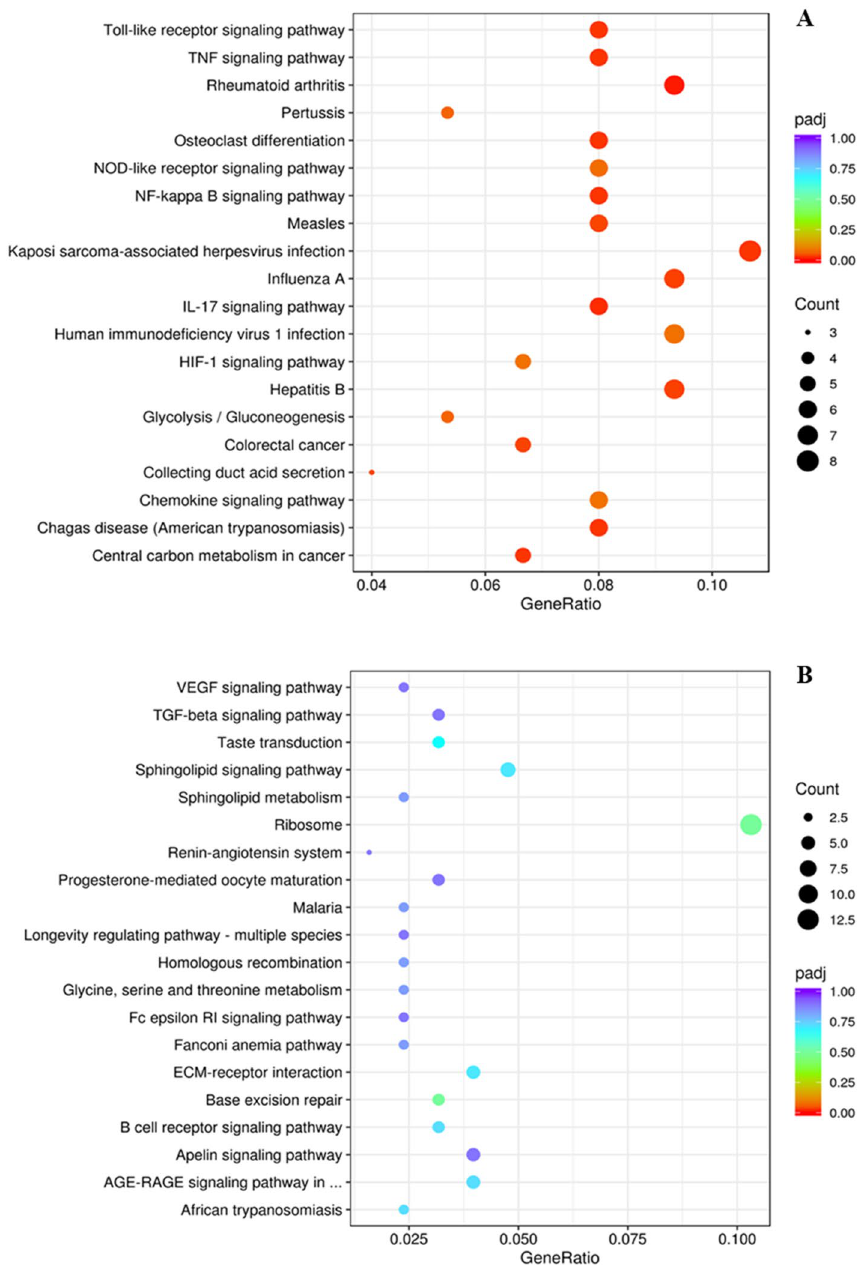
Figure 7. ( A ) Upregulated and ( B ) downregulated KEGG pathways 27 in blood samples from goats subjected to control (not transported but held in pens) versus 30 min (transported for 30 min) stress